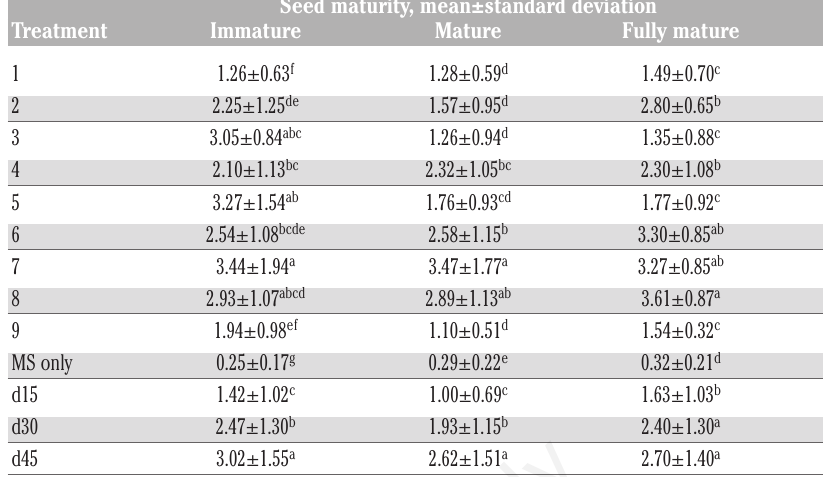
Table 4. Mean callus weight (g) averaged over both plant growth regulators combinations and time intervals (d) for the three different stages of seed maturity. Seed maturity, mean±standard deviation Treatment